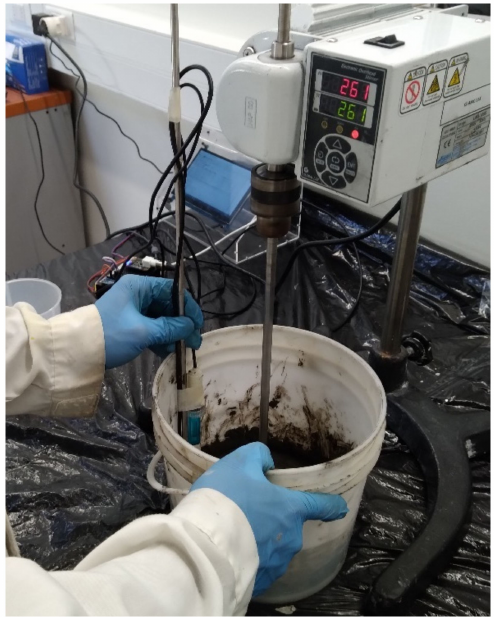
Figure 10. Measurement of pH and temperature during agitation of the